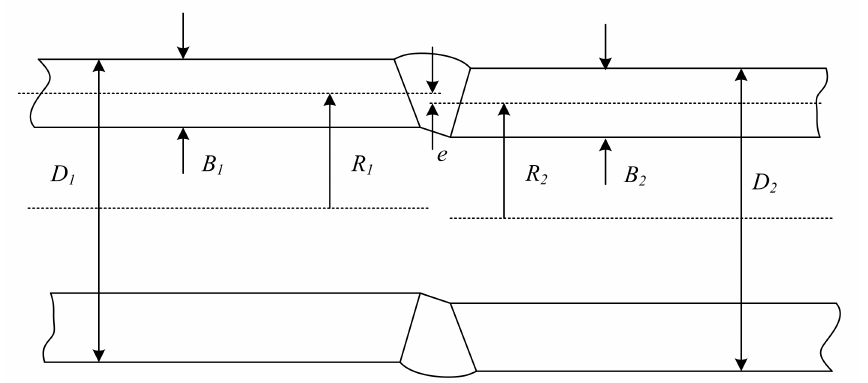
Figure 6. Axial misalignment at girth welds in